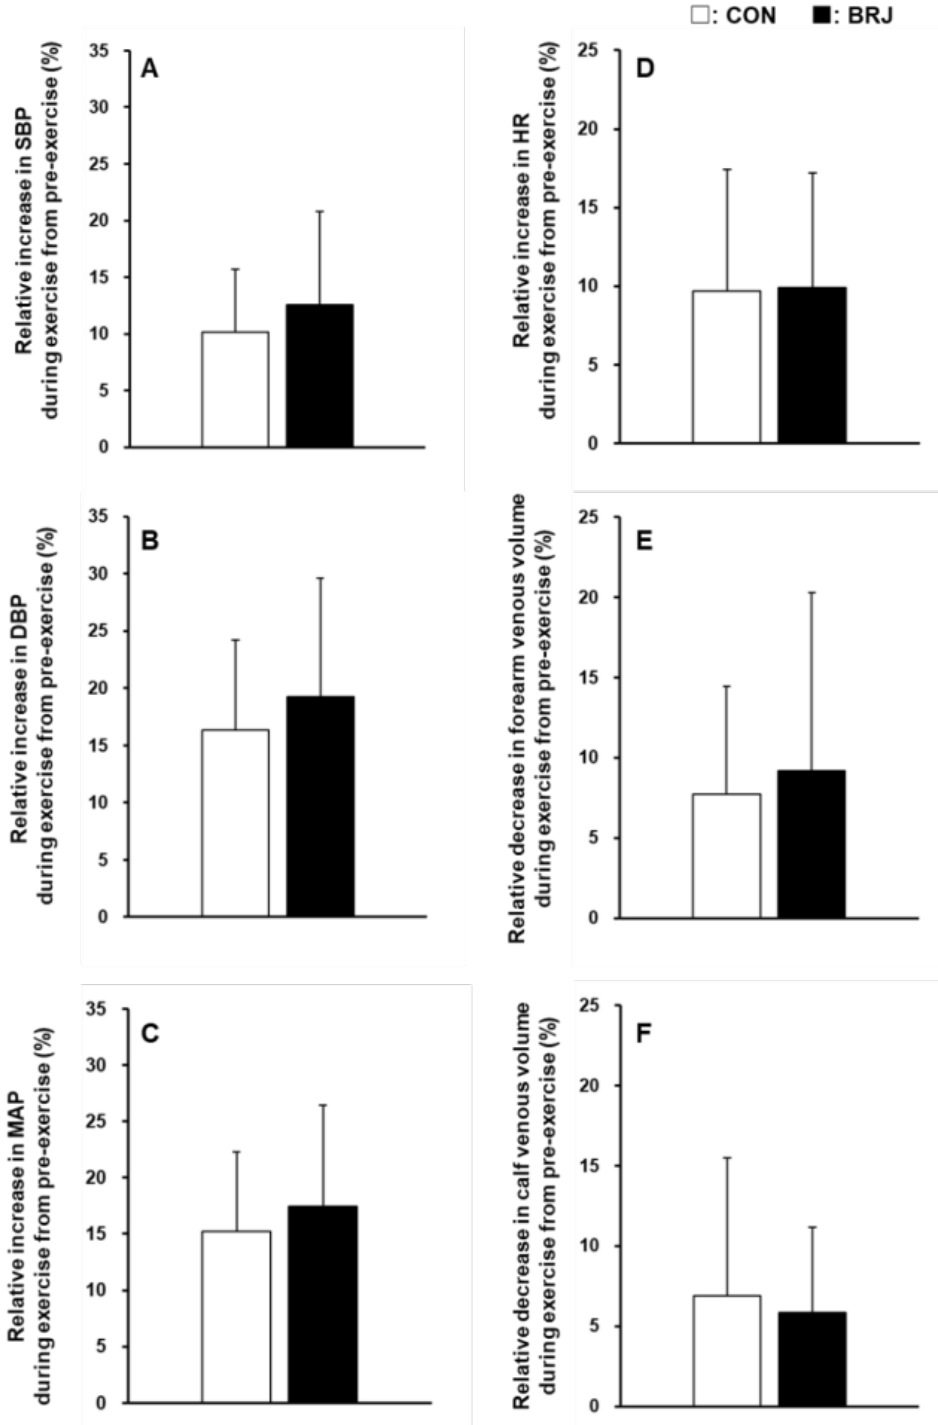
Figure 2. Relative changes in circulatory parameters and venous volume in the non-exercising limbs with static handgrip exercise in CON and BRJ. Percentage increases in the systolic blood pressure (SBP; ( A )), diastolic blood pressure (DBP; ( B )), mean arterial pressure (MAP; ( C )), and heart rate (HR, ( D )) and percentage decreases in venous volume in the forearm ( E ) and calf ( F ) during exercise from pre-exercise. Data are shown as the mean ± standard deviation. CON: NO 3 − -depleted prune juice; BRJ: beetroot juice. Data are expressed as values for n = 16 (10 men and 6